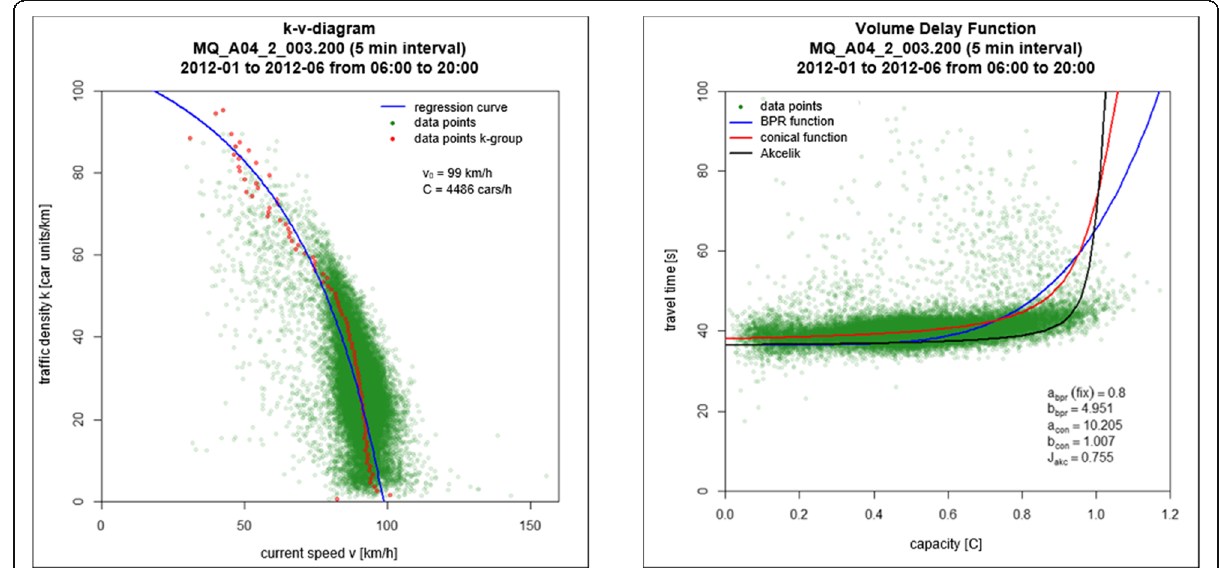
Fig. 6 k-v-diagram and Volume Delay function of the two-lane